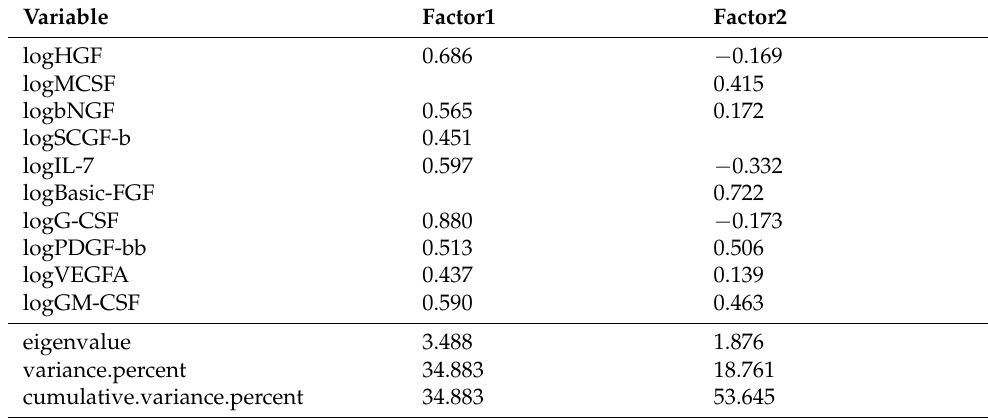
Table 5. Loadings of factors after varimax